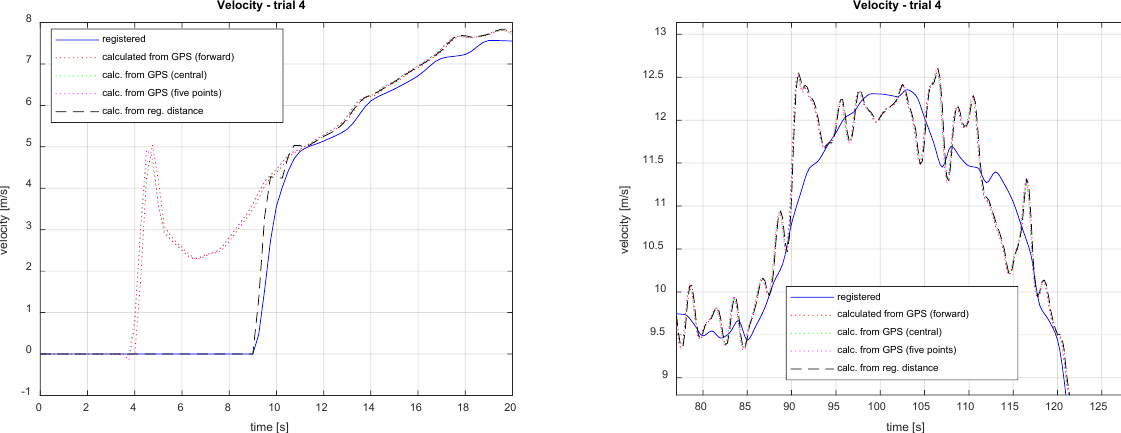
Figure 2. Enlarged parts of the speed chart.